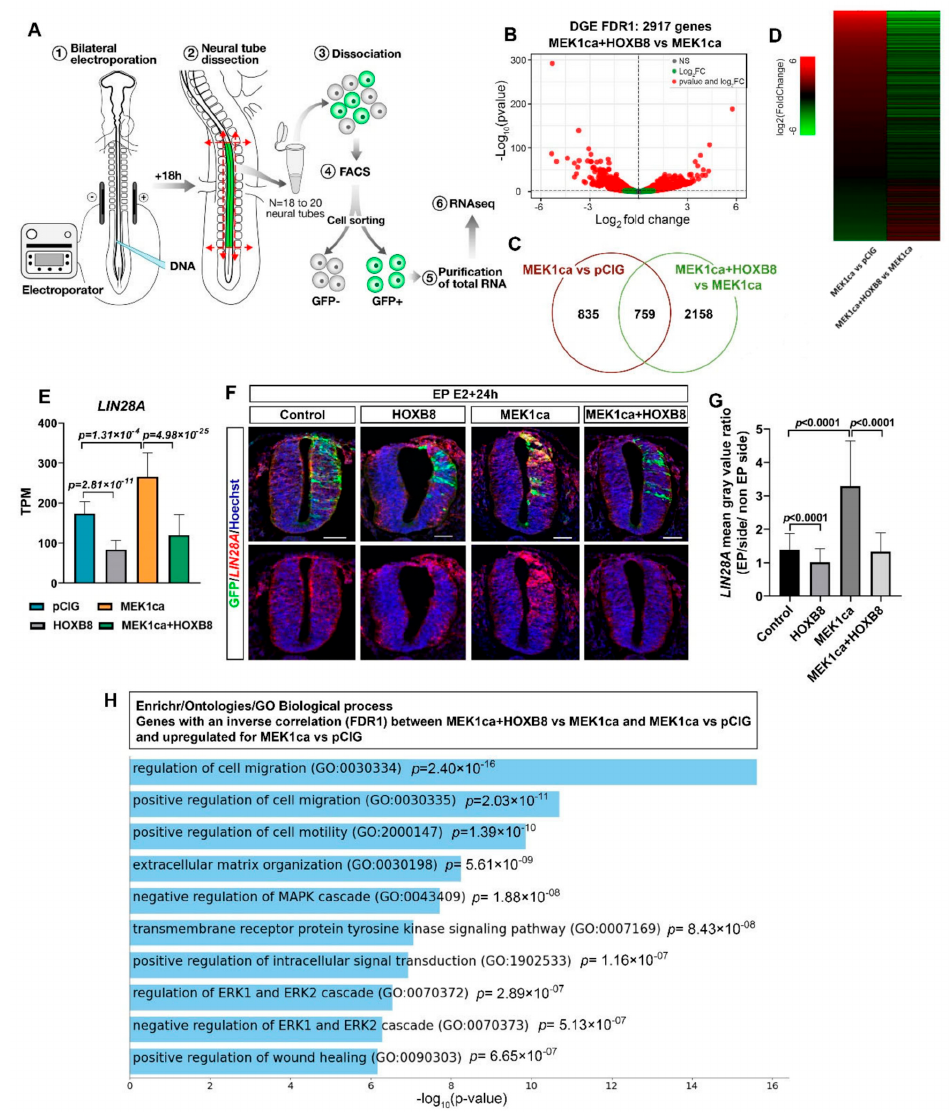
Figure 2. Transcriptomic analysis of MEK1ca-induced neoplasia suppression by HOXB8. ( A ) Experimental design: 18 h after bi-lateral electroporation of the trunk neural tube at stage HH12, the electroporated region of the neural tube was dissected (18–20 embryos per condition in duplicate) and the GFP-positive cells were sorted by FACS. ( B ) Volcano plot of differential gene expression (DGE, FDR1) for the “MEK1ca + HOXB8 versus MEK1ca” conditions (2917 genes). ( C ) Venn diagram showing gene overlaps between the “MEK1ca versus pCIG” and the “MEK1ca + HOXB8 versus MEK1ca” conditions (FDR1). ( D ) Heat map showing the expression of the 759 genes upregulated by MEK1ca and reversed by HOXB8 in “MEK1ca versus pCIG” (line 1) and “MEK1ca + HOXB8 versus MEK1ca” (line 2), highlighting global reversion of MEK1ca-deregulated genes by HOXB8. ( E ) Mean expression of LIN28A TPM (transcripts per kilobase million) obtained for the two replicates of the control- (pCIG1, pCIG2), HOXB8- (HOXB8-1 and HOXB8-2), MEK1ca- (MEK1ca-1 and MEK1ca-2) and MEK1ca + HoxB8 (MEK1ca + HOXB8-1 and MEK1ca + HOXB8-2)-expressing samples, with the corresponding p-value according to the DGE (FDR1) of each pair. ( F ) Fluorescence in situ hybridization with the LIN28A probe and immunofluorescence staining with the anti-GFP antibody on transverse trunk sections of chicken embryos one day post-electroporation in the pCIG, HOXB8, MEK1ca and MEK1ca + HOXB8 conditions. Blue is Hoechst staining. Scale bar: 50 µ m. ( G ). LIN28A expression ratio (electroporated/contralateral side) one day after electroporation in the four conditions ( n = 3 animals/6 sections). The quantifications show that HOXB8 reverses MEK1ca-induced expression of LIN28A (two-tailed Mann–Whitney test, error bars represent the SD). ( H ) Gene ontology enrichment analysis using the Enrichr analytical tool for biological processes (GO Biological Processes 2021), for the upregulated genes in the “MEK1ca versus pCIG” condition among the 759 commonly deregulated genes (FDR1) (between “MEK1ca + HOXB8 versus MEK1ca” and “MEK1ca versus pCIG”), with inverse correlation (519